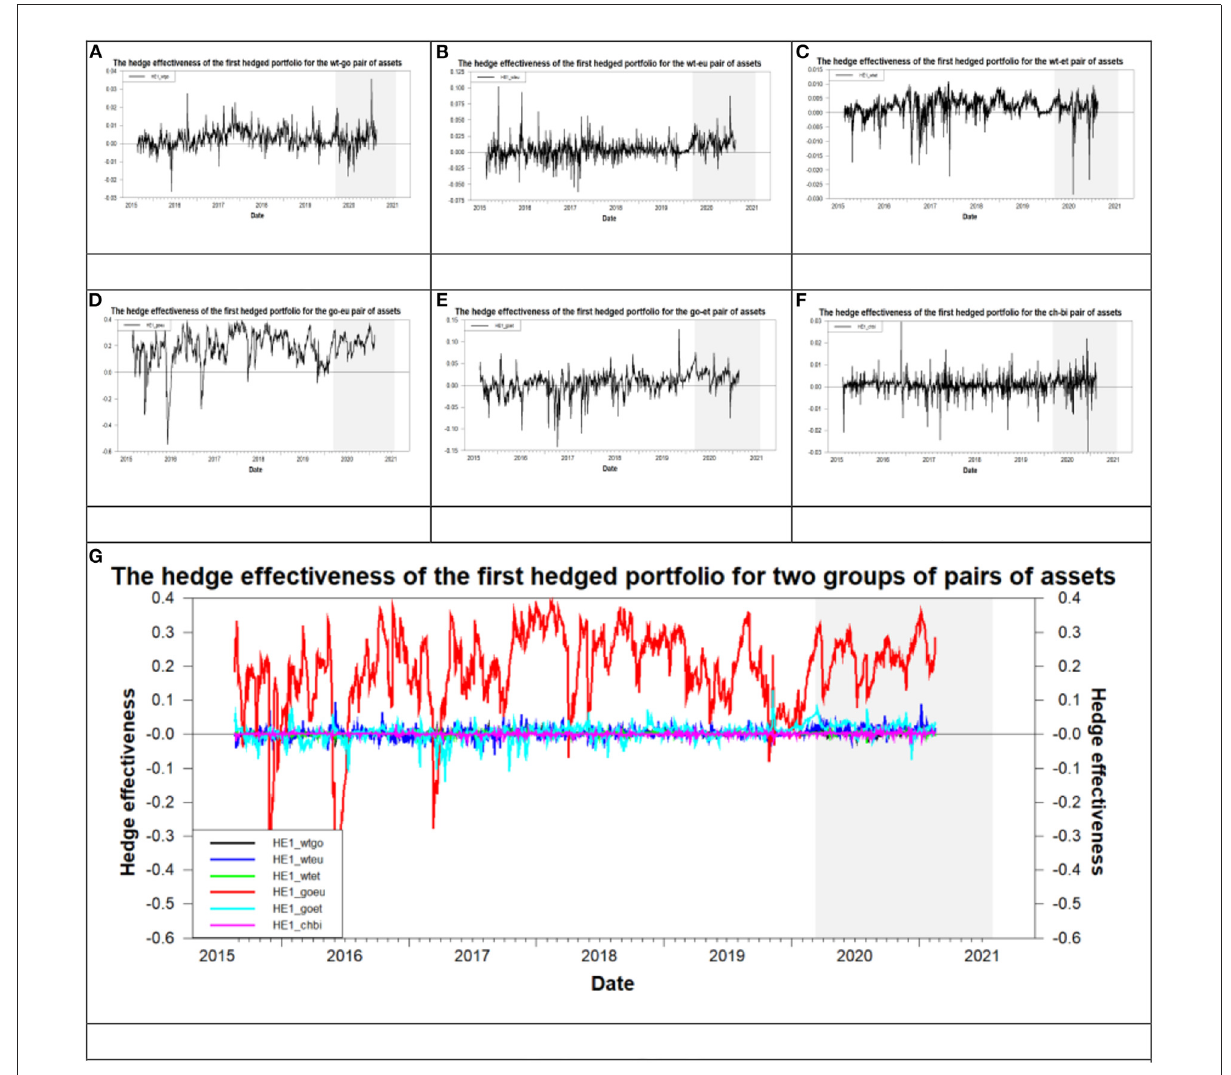
FIGURE8 The time-varying hedge effectiveness for six pairs of assets. (A) wt-go, (B) wt-eu, (C) wt-et, (D) go-eu, (E) go-et, (F) ch-bi, and (G) all six pairs of assets.